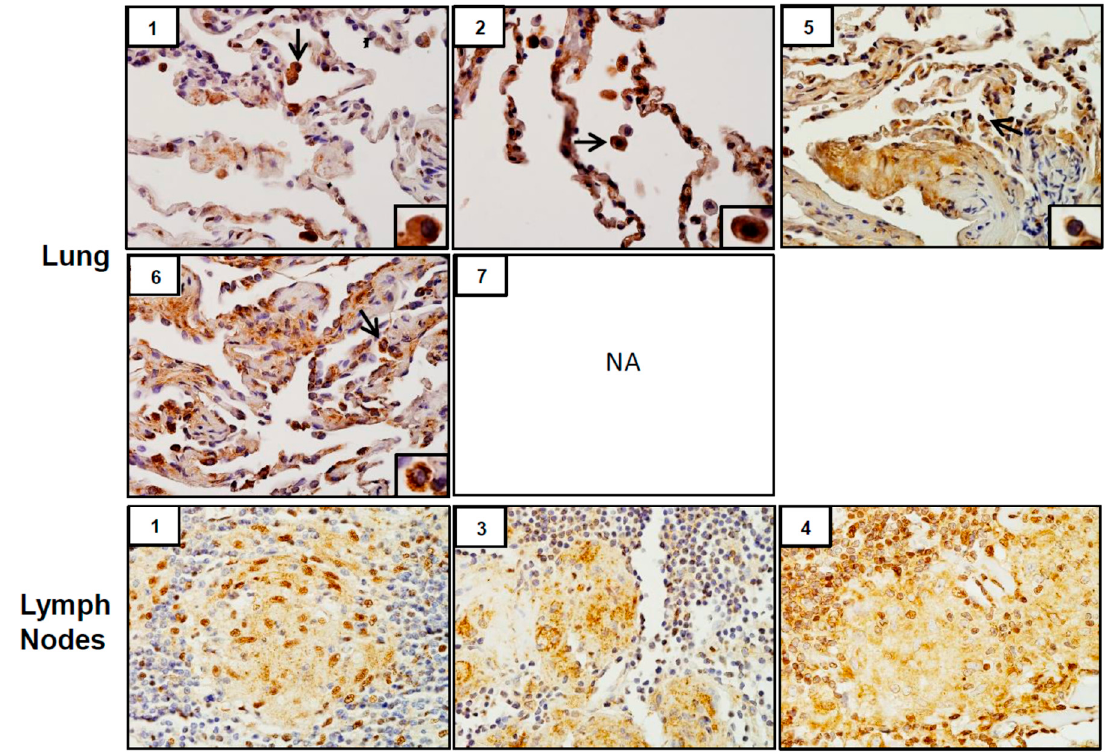
Figure 8. Transforming growth factor (TGF) β expression in lung and/or lymph nodes collected from WTC rescue and recovery workers. Sections were immunostained with antibody to TGF β . Binding was visualized using a DAB peroxidase substrate kit. One representative section from each patient is shown. Inset, patient number; NA, tissue not available. Magnification, 60 × ; arrows, alveolar macrophages.